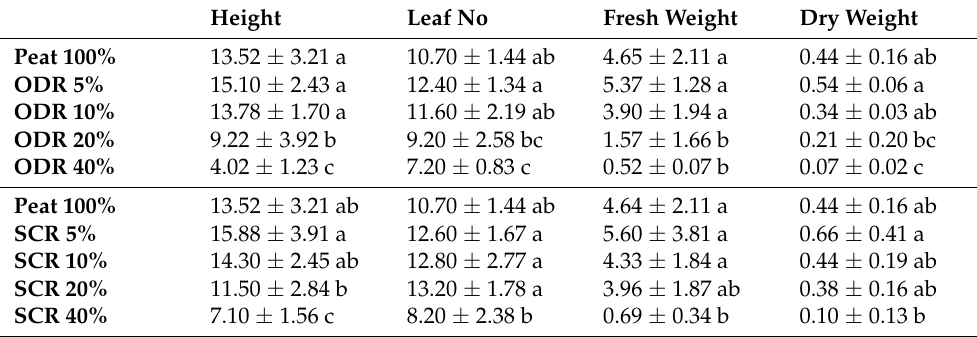
Table 3. The effect of growing media (peat, O. dubium residue—ODR, and S. cypria residue—SCR) on the sowthistle seedlings’ height (cm/plant), leaf number, upper part fresh weight (fw; g/plant), and dry weight (dw; g/plant) on plants grown in the greenhouse/nursery. Height Leaf No Fresh Weight Dry Weight